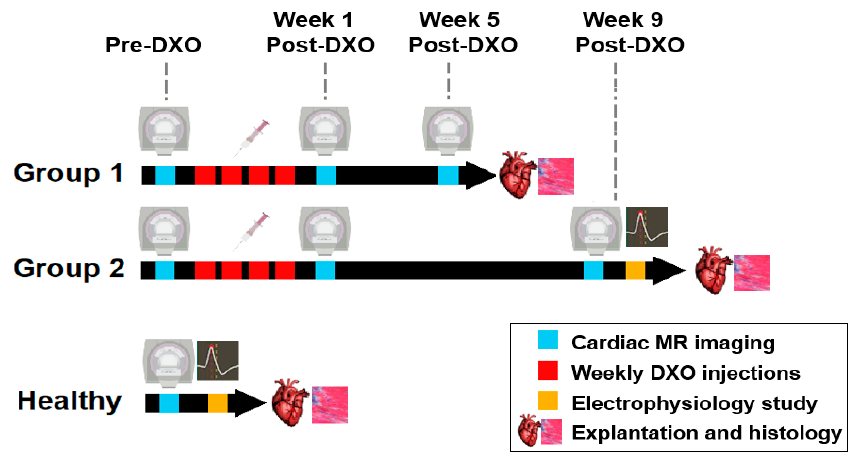
Figure 1. Pipeline of the experimental study to evaluate DOX cardiotoxicity pre- and post-treatment, as indicated by the arrows (the arrowheads point to the end of longitudinal studies).